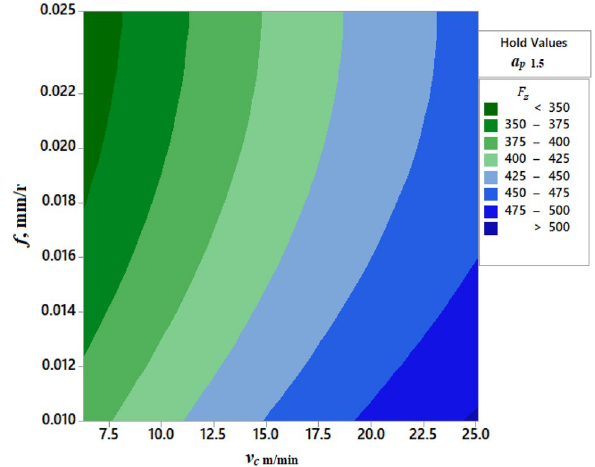
Fig. 16 Cutting force F z vs f , and v